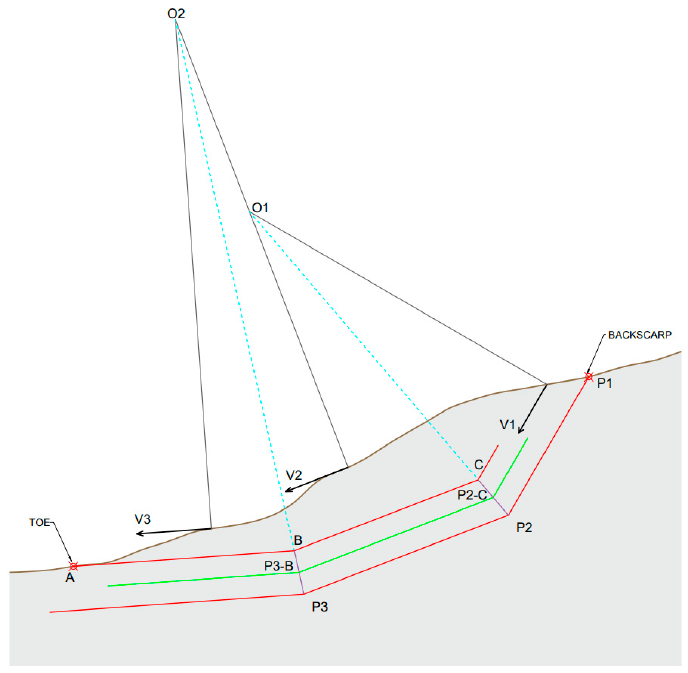
Figure 8. Schematic representation of VIM method.